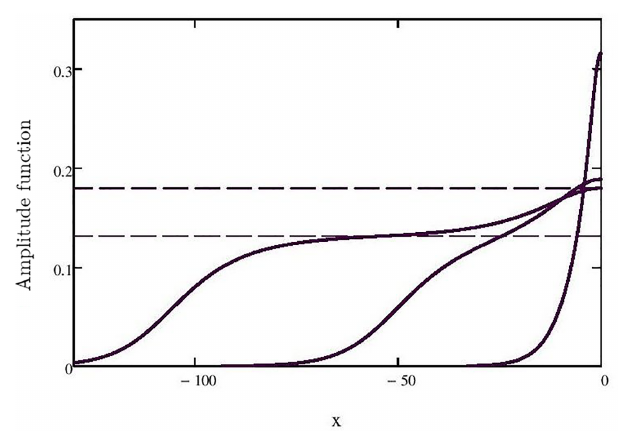
Figure 7. Profiles of unstable solitary waves are shown by solid lines. Dashed lines: A 2 = 0 . 1311; A 1 = 0 . 1793. The lower limiting wave amplitude is A 0 = A 1 .